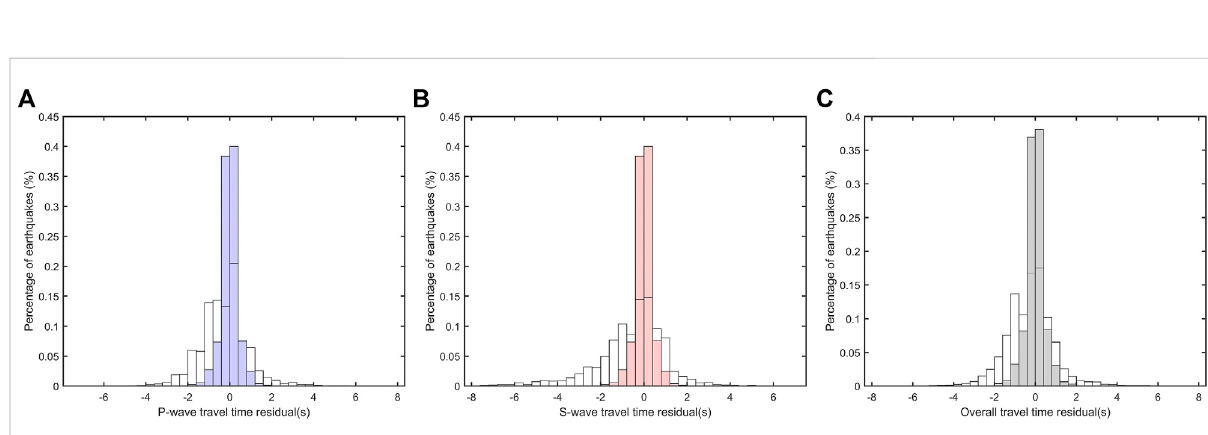
FIGURE 5 The colored fi lled histograms (blue fi lled, red fi lled, gray fi lled) represent the P-wave (A) , S-wave (B) and Overall travel time (C) residuals after relocate, respectively; The un fi lled histograms represent the initial travel time